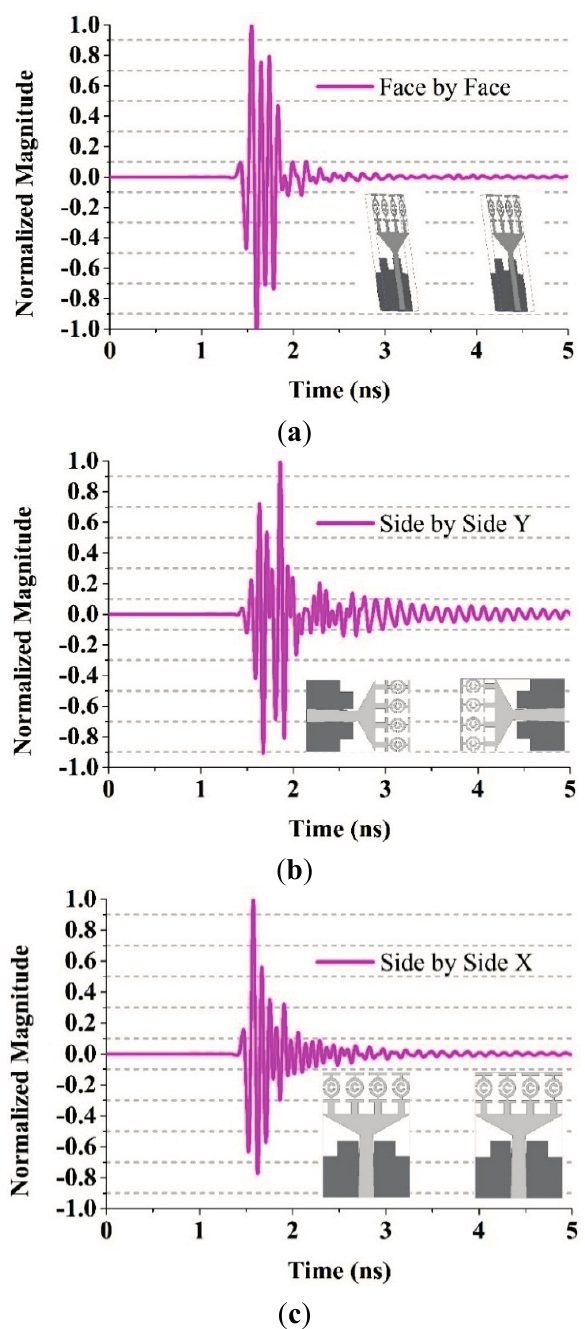
Figure 21. Pulse transmission analysis in different orientation of the proposed fractal UWB antenna. ( a ) Face-to-face; ( b ) Side-by-side Y; ( c ) Side-by-side